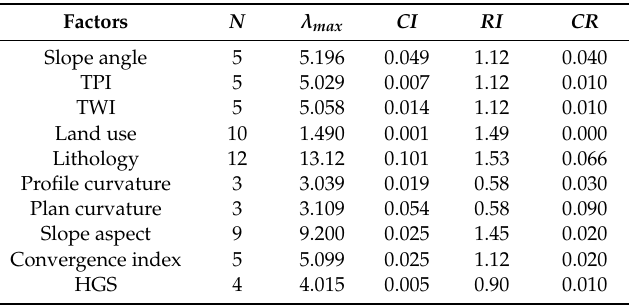
Table 2. Properties of comparison matrices in the previous